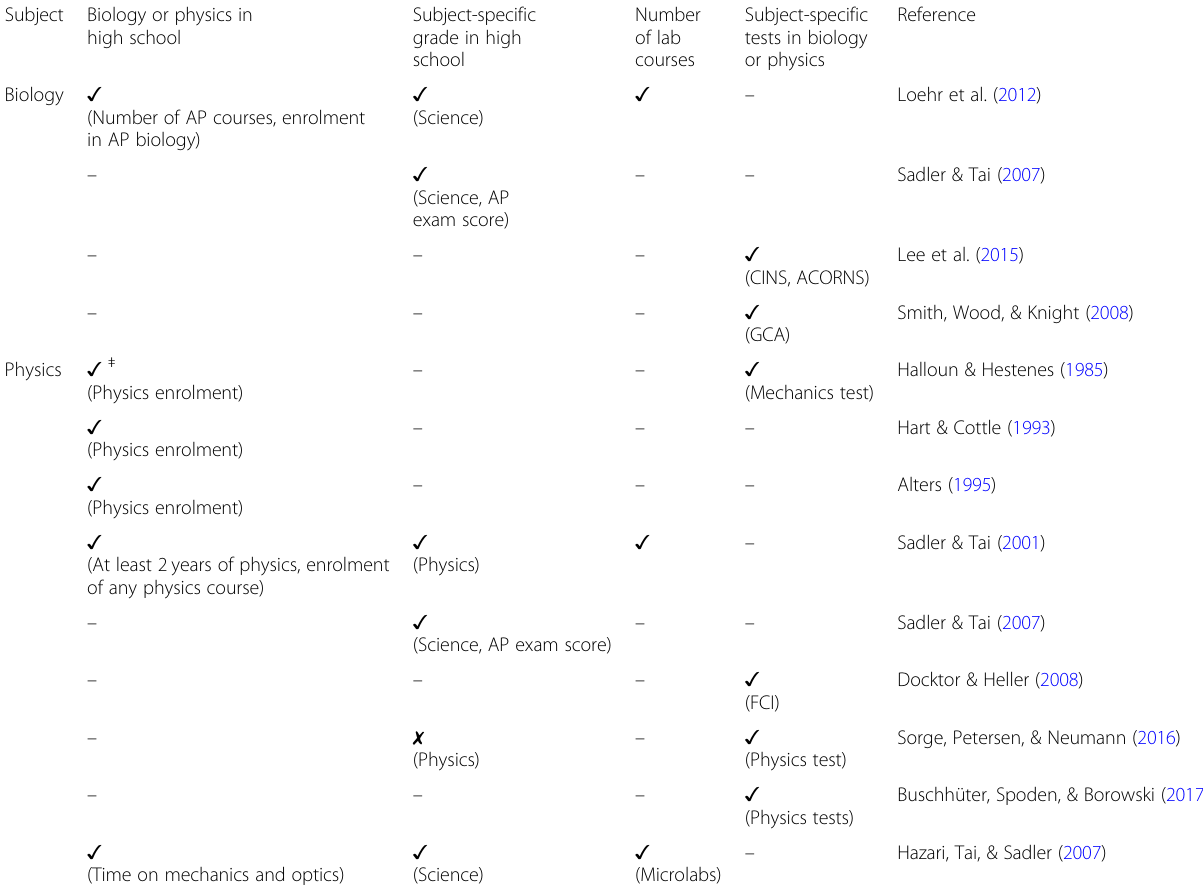
Table 1 Overview of significant cognitive predictors for academic achievement in science courses at university or